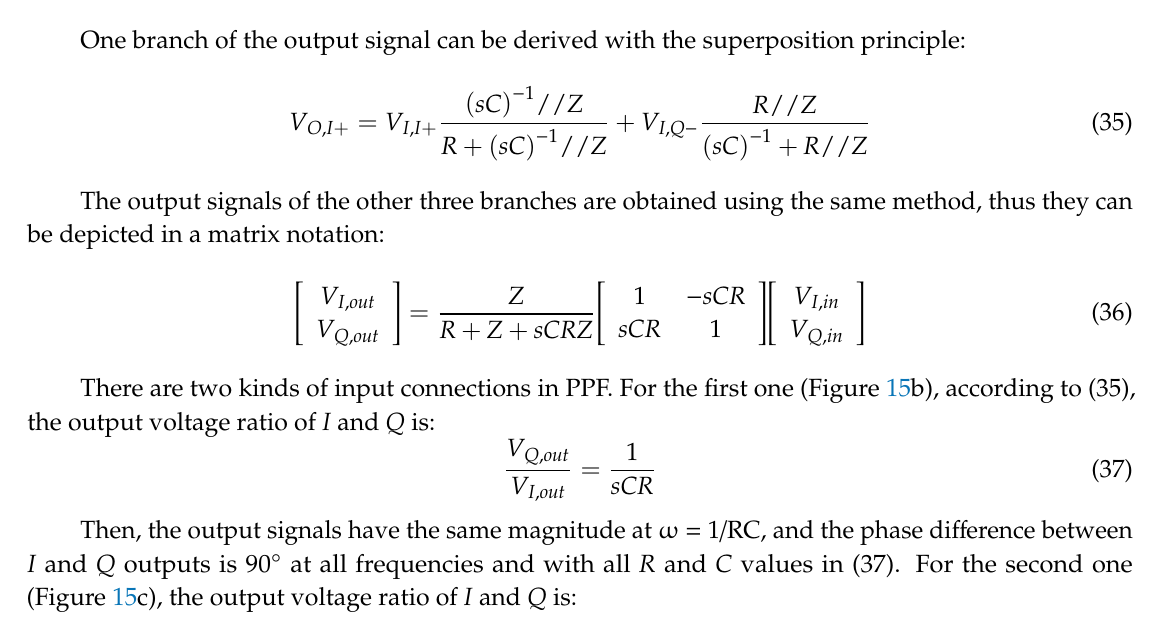
Figure 15. ( a ) PPF (polyphase filter) with load and ( b , c ) two input connection methods.